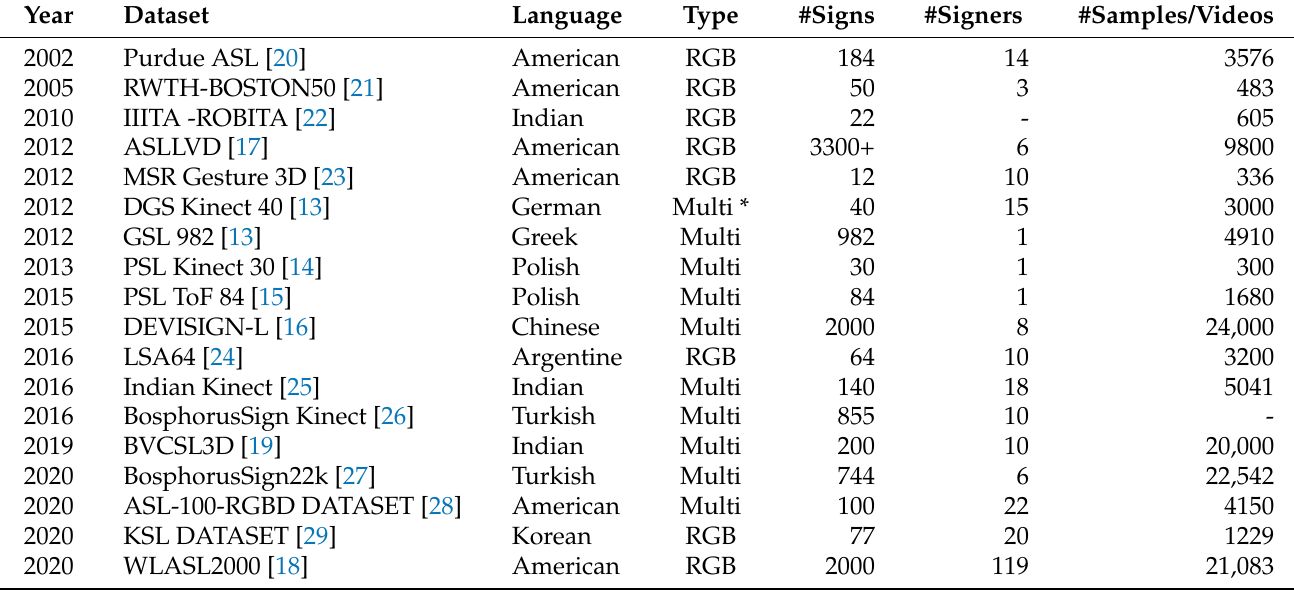
Table 1. Publicly available sign language datasets in other